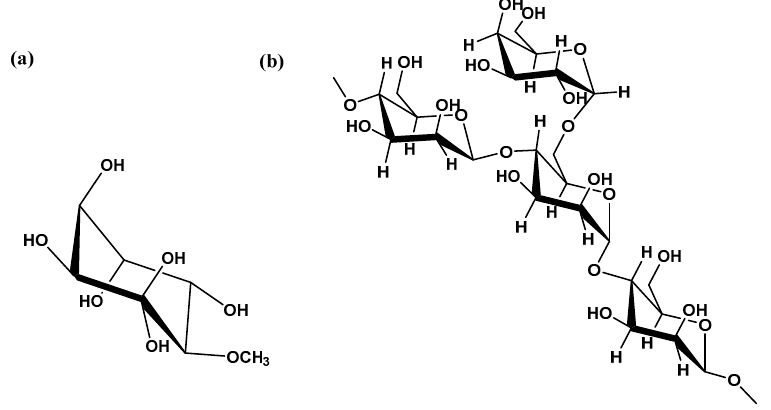
Figure 2. Chemical structures of ( a ) D -pinitol and ( b ) locust bean gum (LBG).